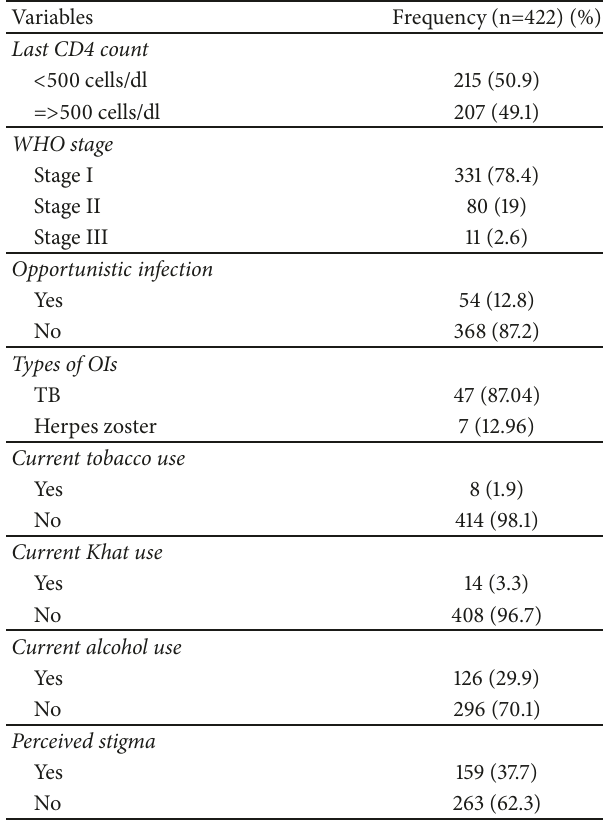
Table 2: Clinical, substance use and perceived stigma of the participants among PLWHA at three selected hospitals ART clinics, North Shewa Zone, Amhara regional state, Ethiopia, 2017